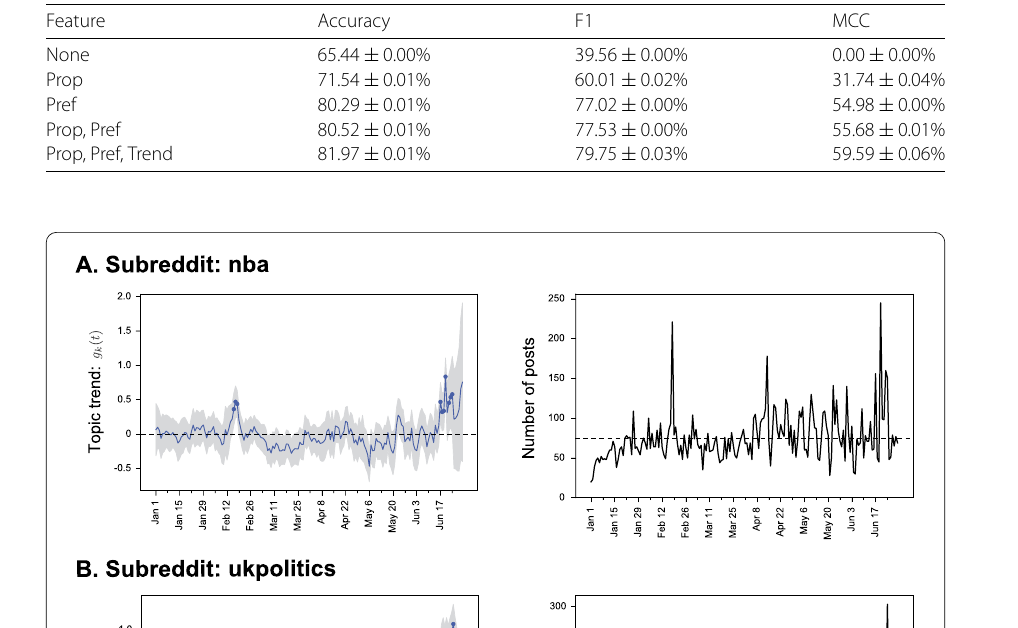
Table 8 Effect of author property and topic trend on the prediction performance (Twitter). The mean and the 99% confidence interval for 200 trials are shown